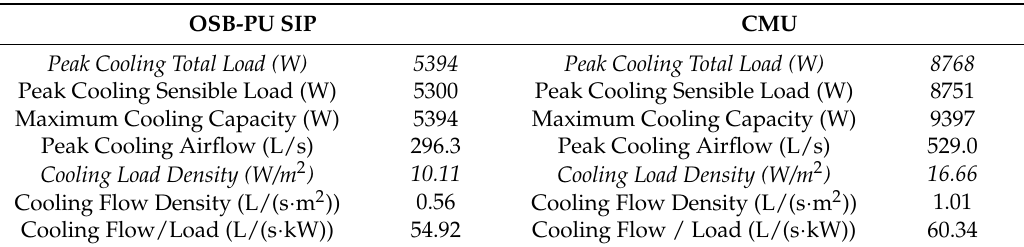
Table 4. OSB-PU SIP vs. CMU energy simulation for the same ‘complete’ house model using Energy Analysis Plug-in (Insight 360) for Revit